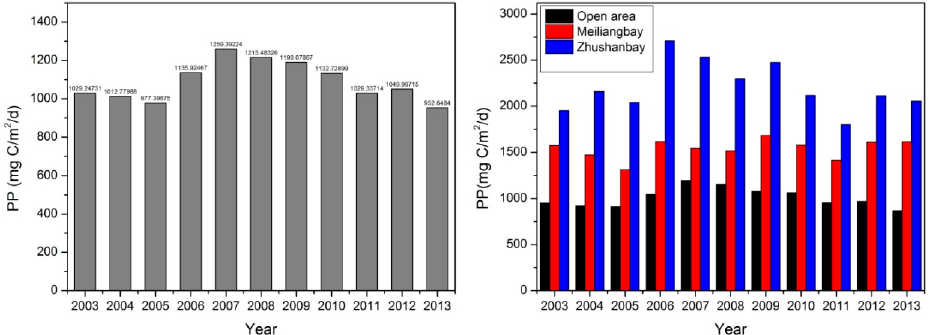
Figure 3. Annual variations of phytoplankton primary production in Lake Taihu from 2003 to 2013.